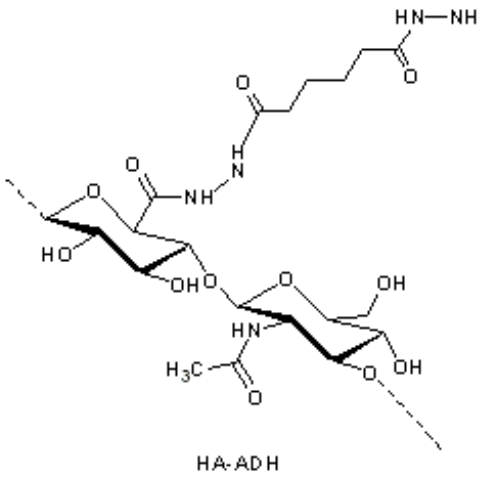
Figure 2. Hyaluronic acid (HA)-adipic dihydrazide (ADH) intermediate for further derivatization with paclitaxel